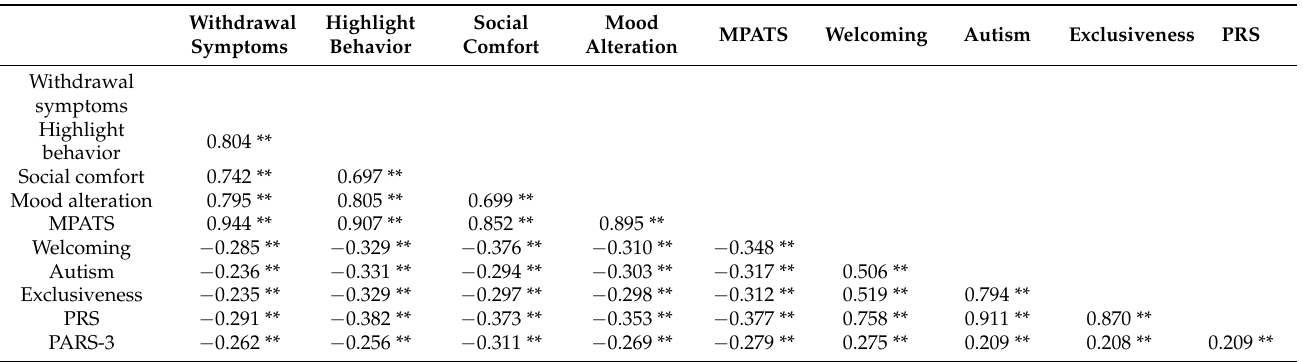
Table 4. Results of the correlation analysis.